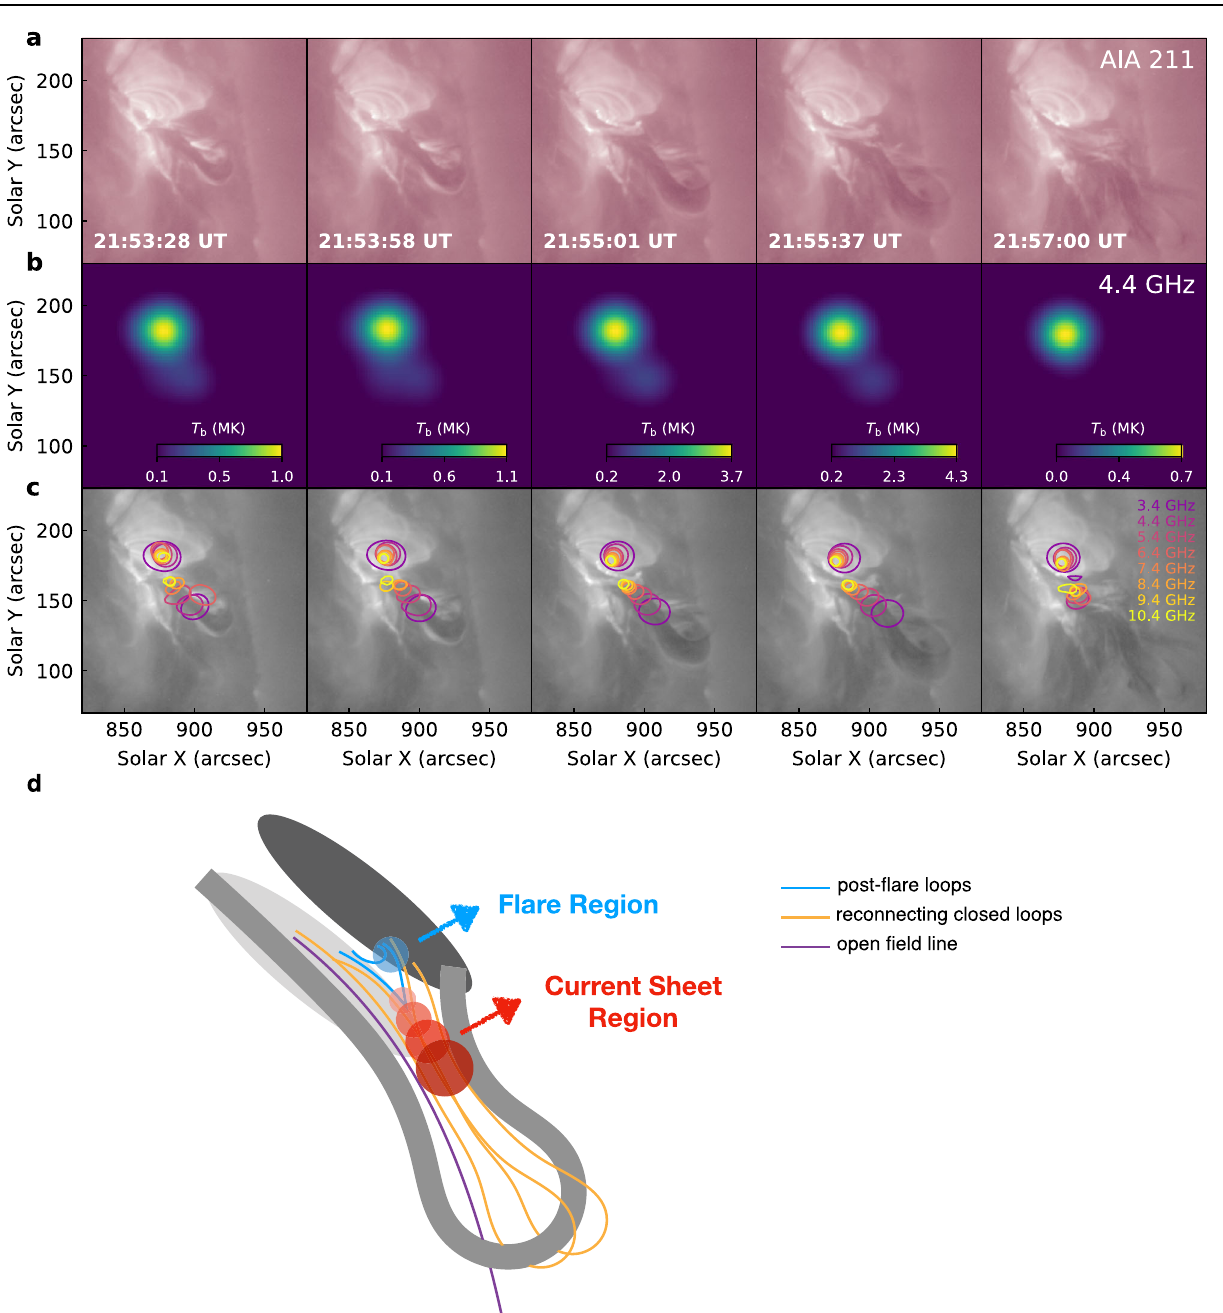
interpreting the magnetic fi eld structure during the eruption. The wide curve in grey represents the erupting fi lament with the overlying fi eld in gold and purple. The ovals in shallower and deeper grey represent magnetic positive and negative polarities, respectively. The circles in blue and red, from shallower to deeper with decreasingfrequency, indicatethe strong and weakmicrowave sources locating at the fl are loops and reconnection CS region,